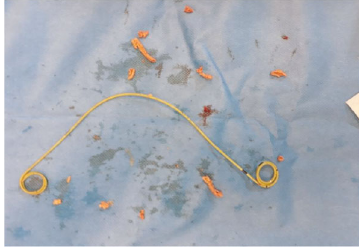
Figure 2: DJ stent and surrounding fungal tissue.